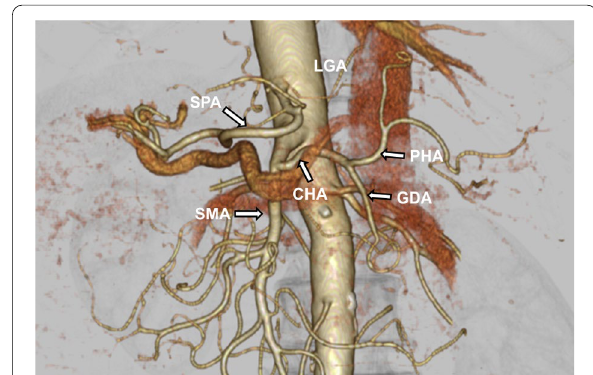
Fig. 3 Three-dimensional reconstruction image of CT angiography preoperative findings. The common hepatic artery (CHA) originated